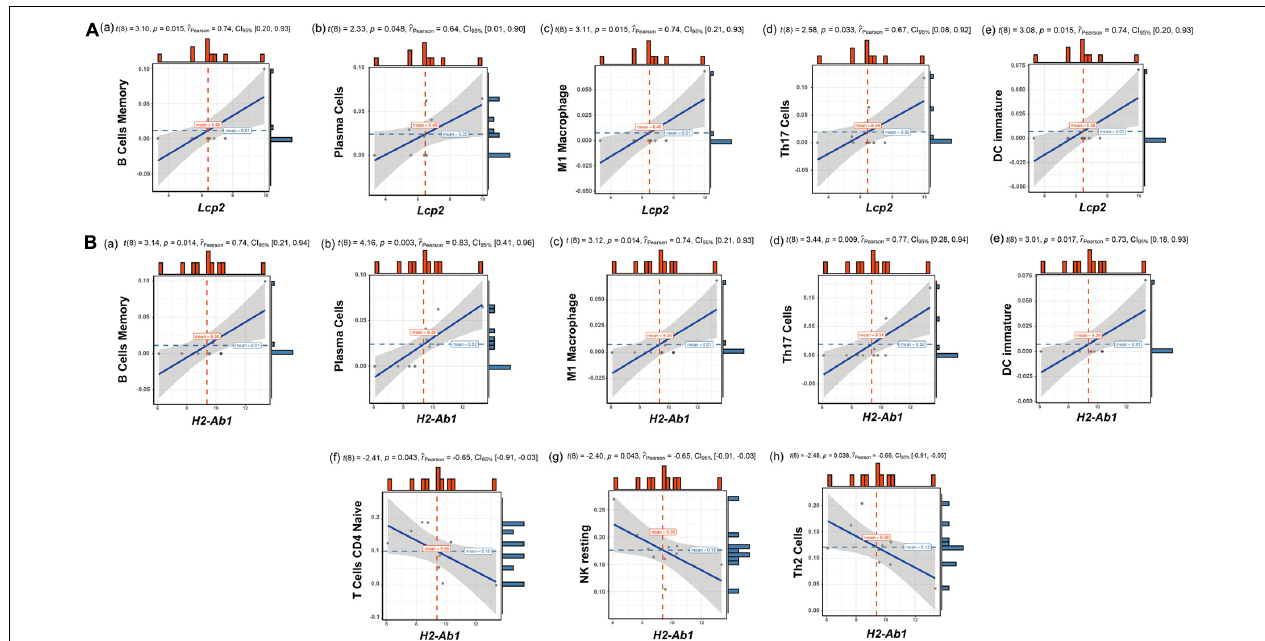
FIGURE 6 | Correlation analysis of Lcp2 , H2-Ab1 , and their responding immune cell types. Correlation analysis of Lcp2 and the listed immune cell types (A) : memory B cells (a), plasma cells (b), m1 macrophages (c), Th17 cells (d), and immature dendritic cells (e). Correlation analysis of H2-Ab1 and the listed immune cell types (B)